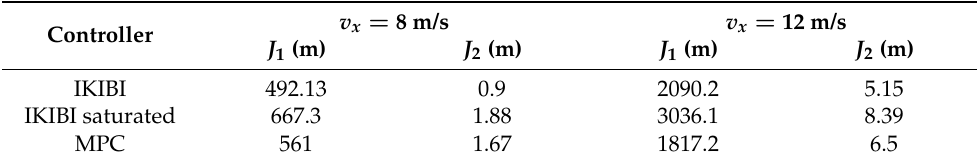
Table 1. Cost indexes: noiseless, fast sensor feedback